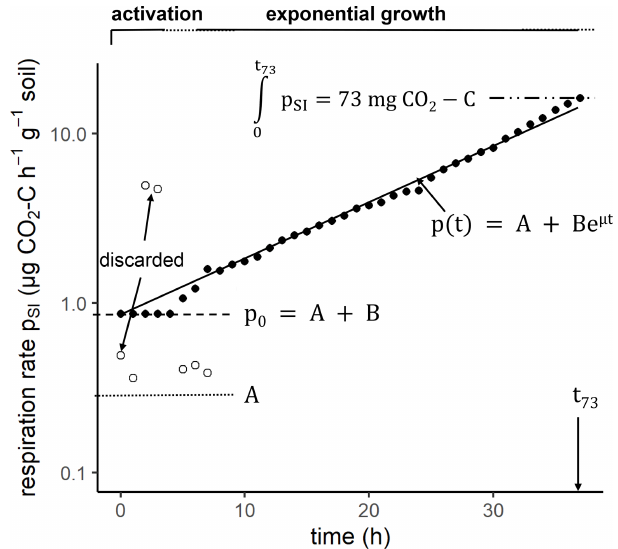
Figure 2. Example of a time series of CO 2 release after glucose addition at t = − 1h and first measurement at t = 0h. The fluctu- ations in CO 2 readings during the first hours (empty circles) were discarded and replaced by a constant substrate-induced respiration rate p 0 during an initial lag phase. The parameters µ , A , B and p 0 are derived from a model fit, whereas t exc (time until a total of 73mgCO 2 -C was respired) is directly calculated from the time se-